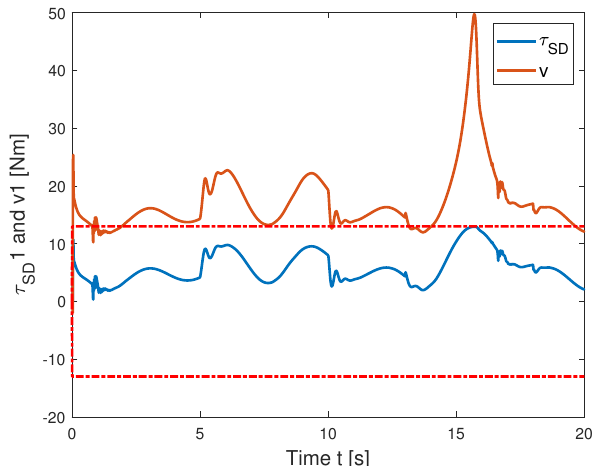
Figure 9. q 2 position trajectory and tracking error e 12 (NNs-based control).